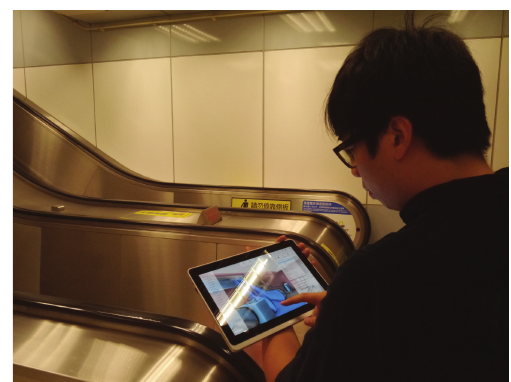
Figure 6: Staff using webcam-enabled tablet for FMM work in the pilot case.